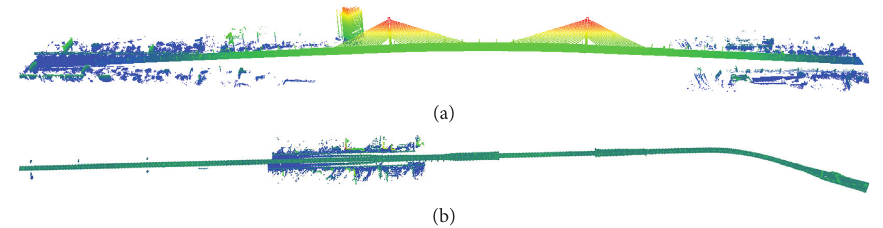
Figure 3: Point clouds of two test sites. (a) Site 1 and (b) Site 2.